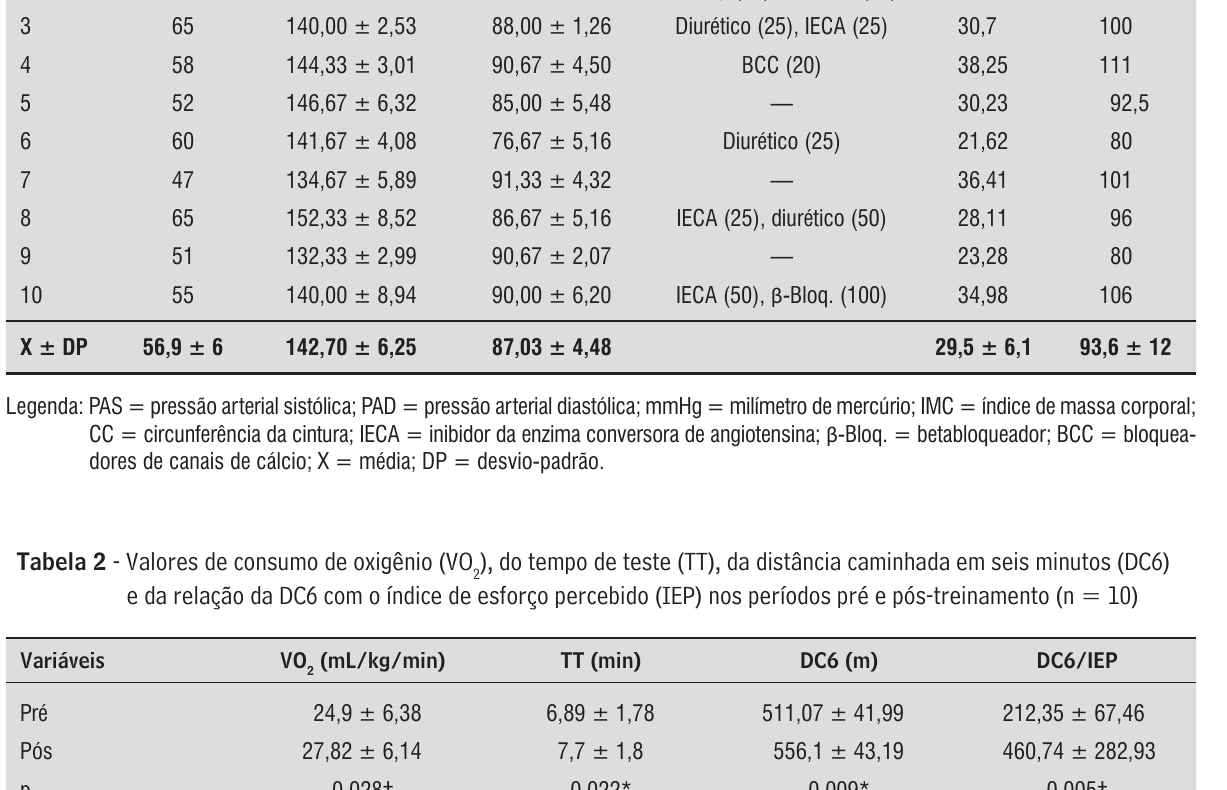
Tabela 1 - Características individuais das voluntárias no início do estudo